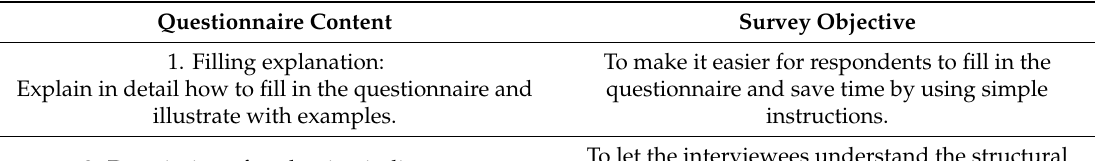
Table 5. The fuzzy Delphi expert questionnaire description.